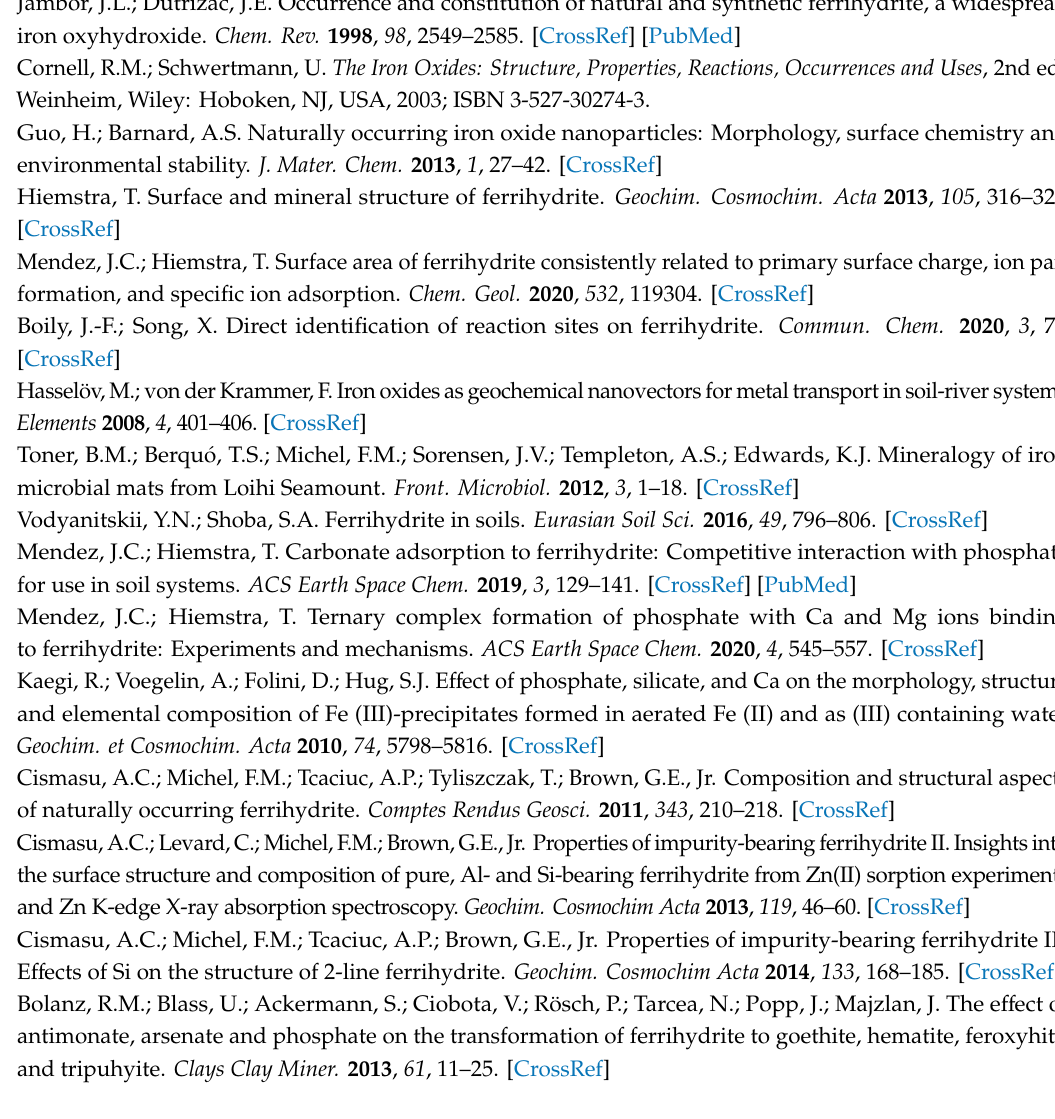
Figure S6: SEM image and EDS spectra of products of P-rich ferrihydrite (FHYD-1.0) heating to 800 ◦ C ( A ) and to 1000 ◦ C ( B ), Table S1: Comparison of the position of major thermal e ff ects apparent on DTA curves for pure and P-doped